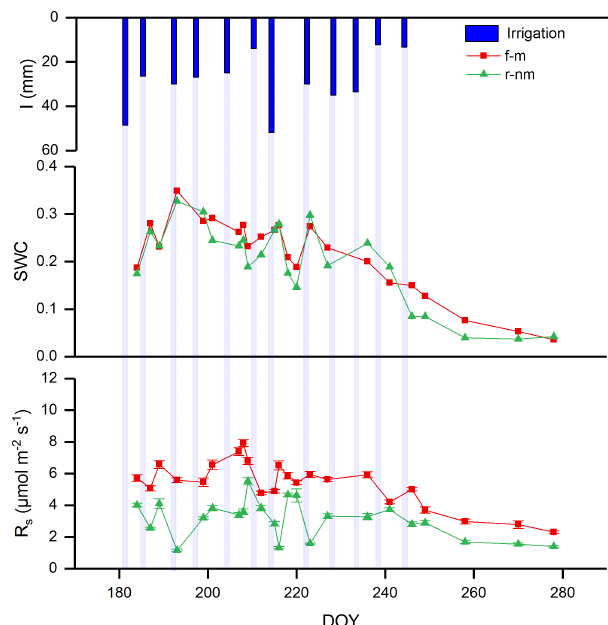
Figure 6. The responses of soil moisture and respiration to irriga- tion at different locations in the mulched and non-mulched fields in 2014 (f-m and r-nm represent the furrow in the mulched field and the ridge in the non-mulched field, respectively).